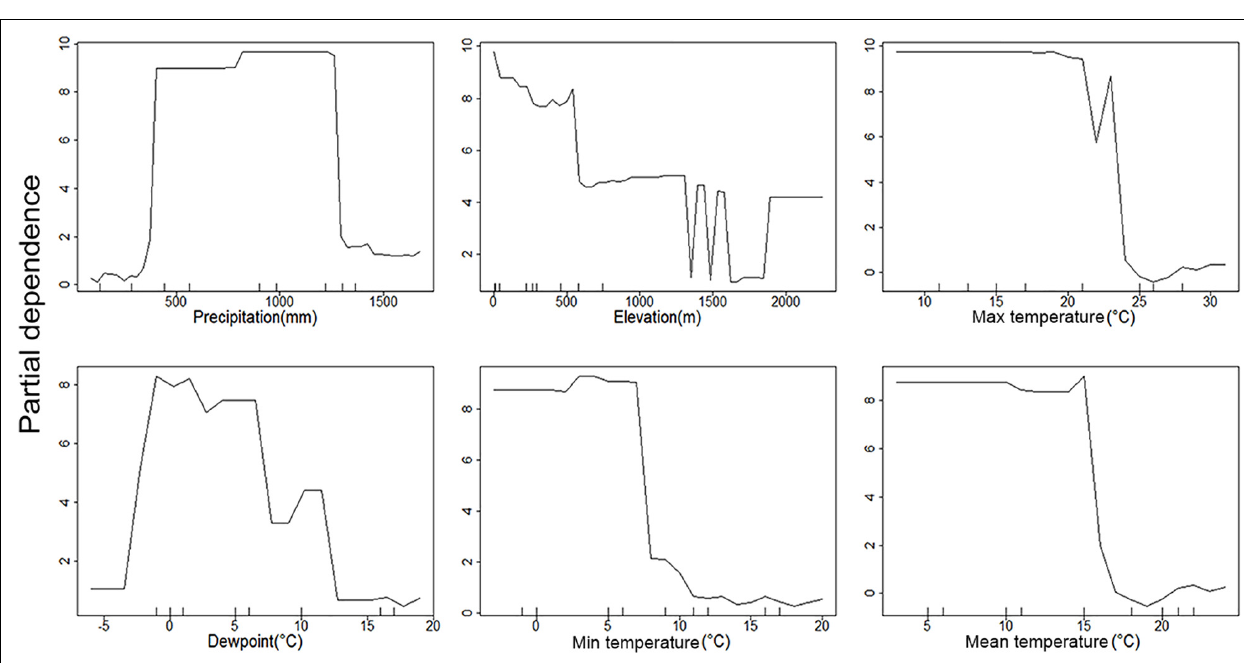
populations, and stochastic events are more likely to result in the loss of said populations. The disparity in sensitivity of the two mosquitoes may be due to differences in life-history